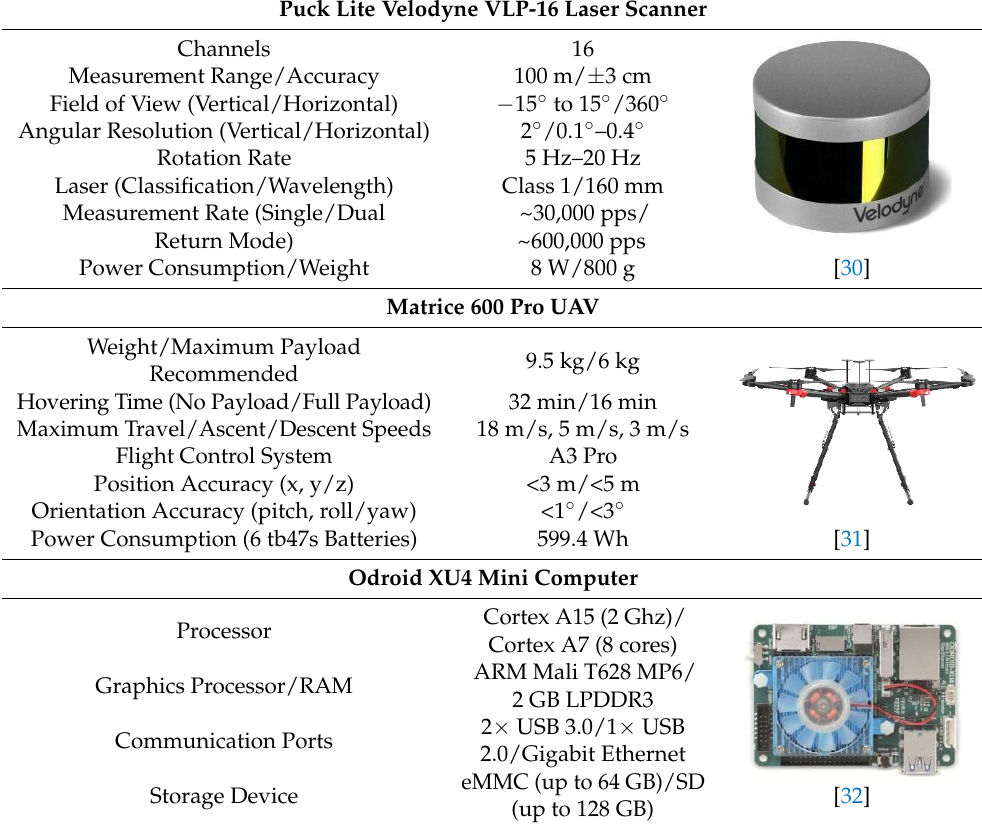
Table 1. Equipment specifications.